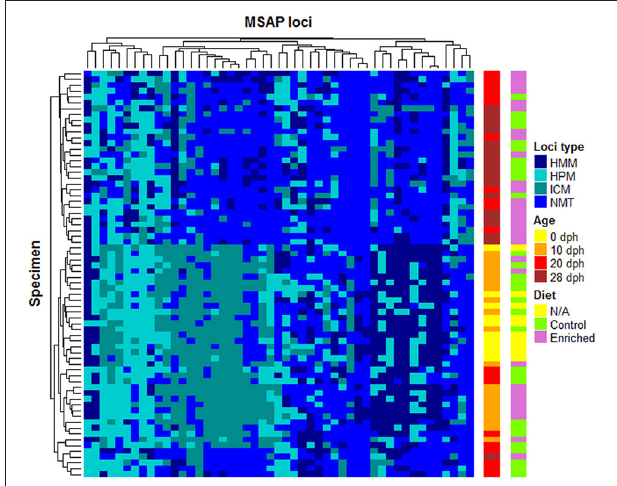
FIGURE 3 | Heatmap of 51 highly differentially methylated MSL of O. vulgaris paralarvae. Specimens (rows) and loci (columns) were clustered by the average linkage method. These 51 MSL are the most highly differentially methylated loci identified by Fisher’s test ( P < 0.05). Diet (N/A for 0 dph because have not received diet) and age are shown at right side of the